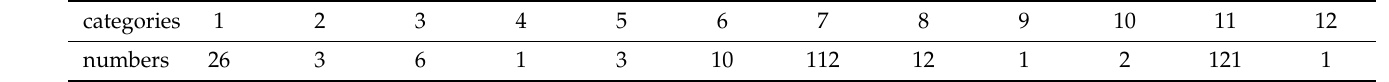
Table 1. The cluster results and the compound number contained in each